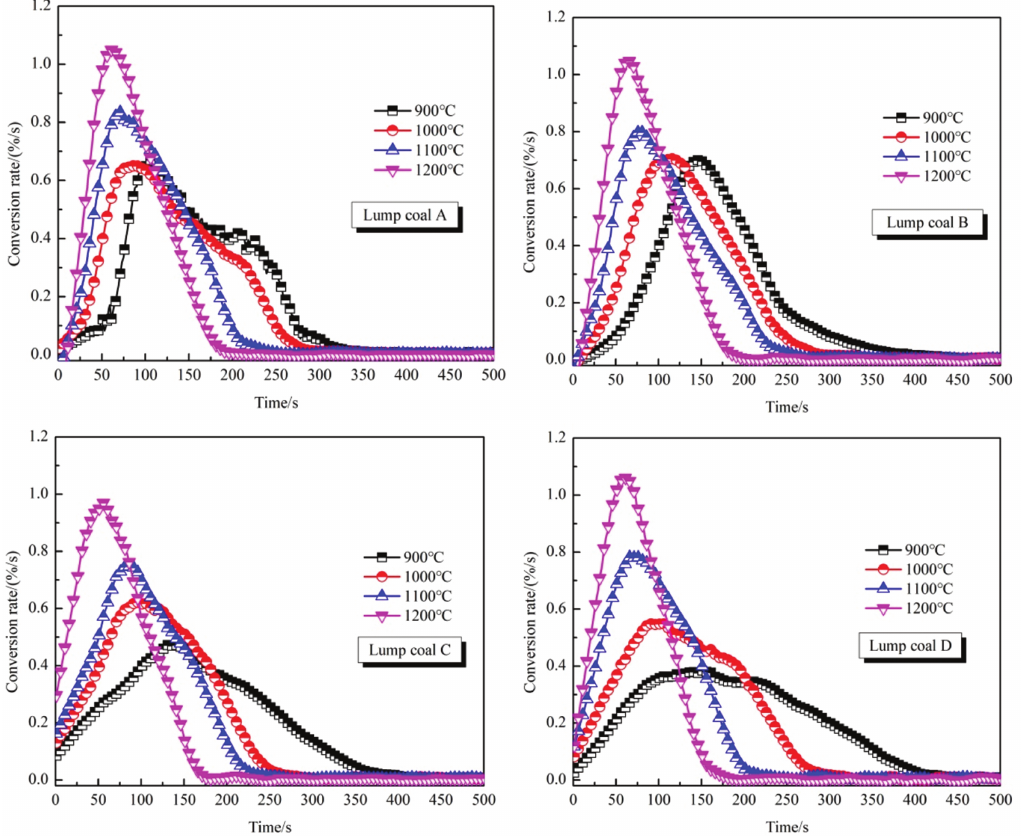
Figure 5: Conversion rate of lump coal at different temperatures.